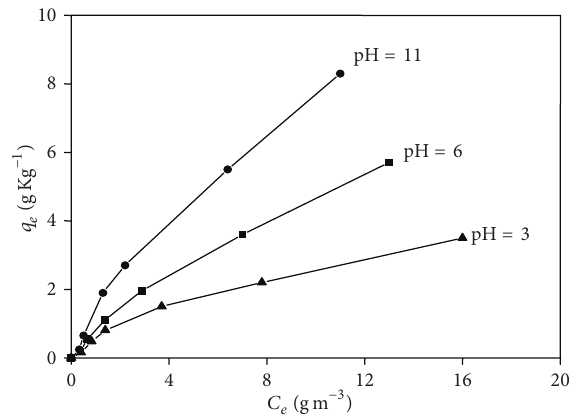
F 6: Equilibrium adsorption of methyl orange on untreated cellulose �bers (